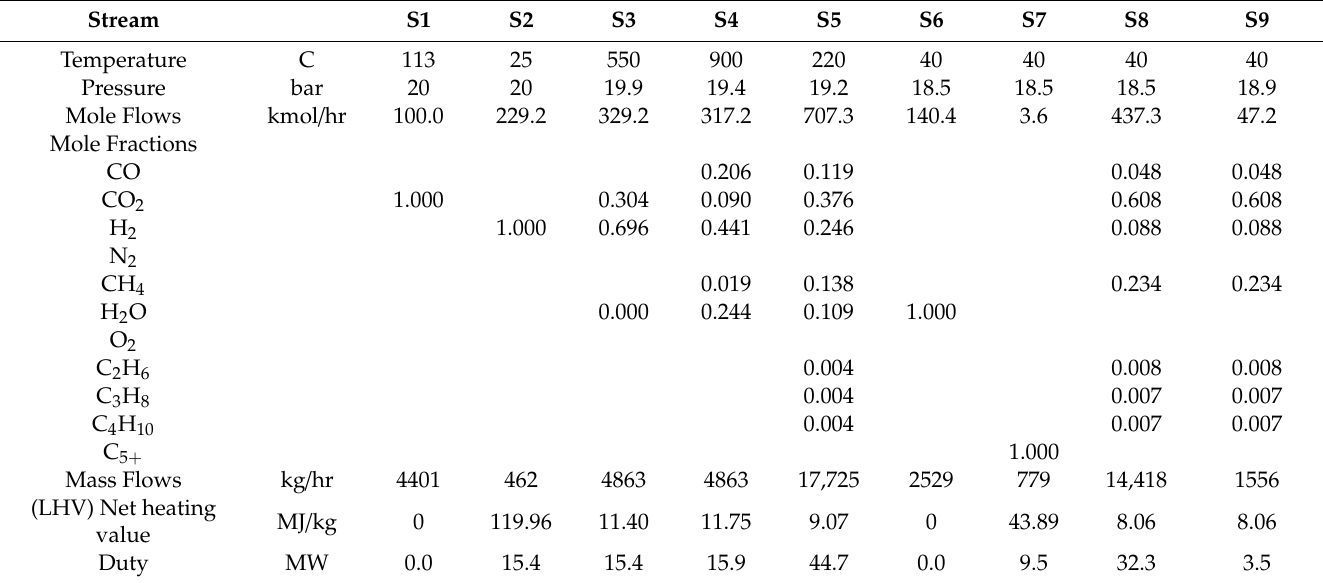
Table A1. Simulated stream results for